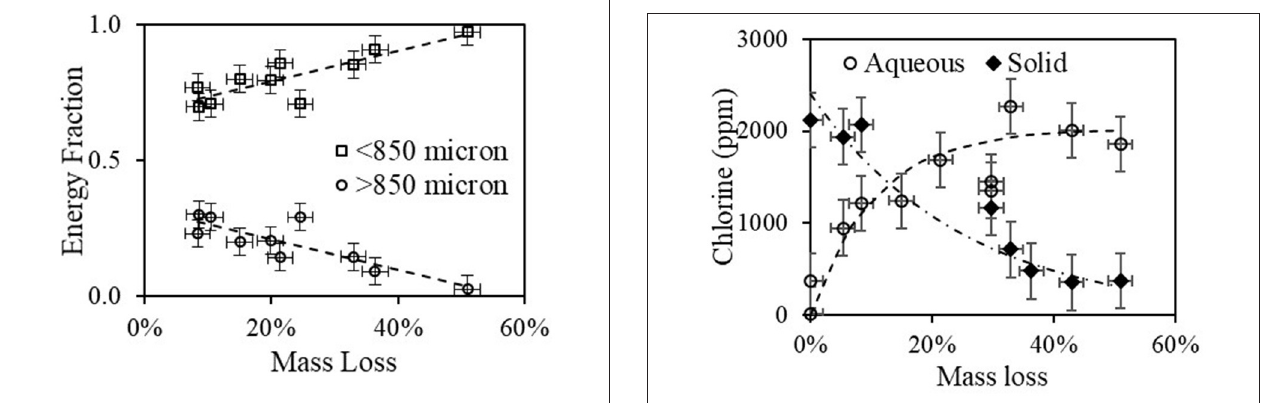
FIGURE 13 | Chlorine in solid filtrate after high shear mixing and chloride in the aqueous solution (adjusted for